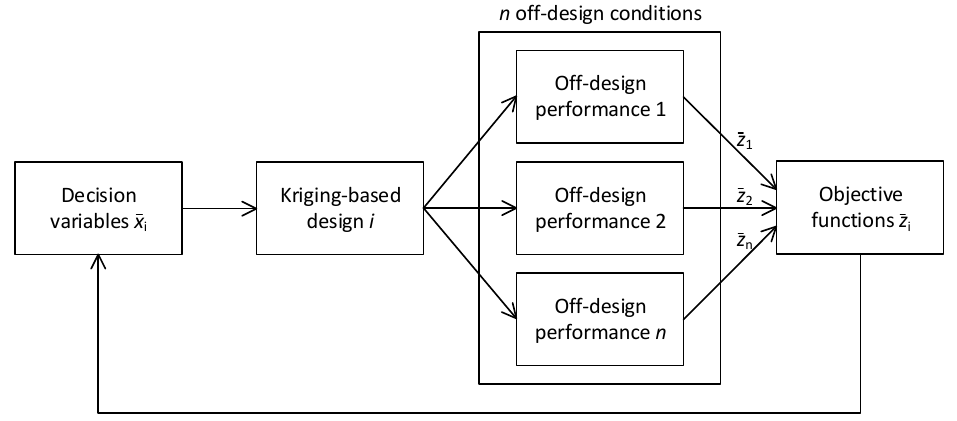
Figure 2. Flowchart of the optimisation procedure